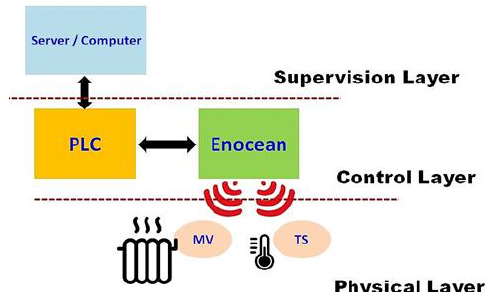
Figure 3. Implementation diagram of the heating system equipping Building A of Senart Campus of University Paris-Est Créteil (UPEC). PLC, programmable logic controller; MV, motor valve; TS, temperature sensor.